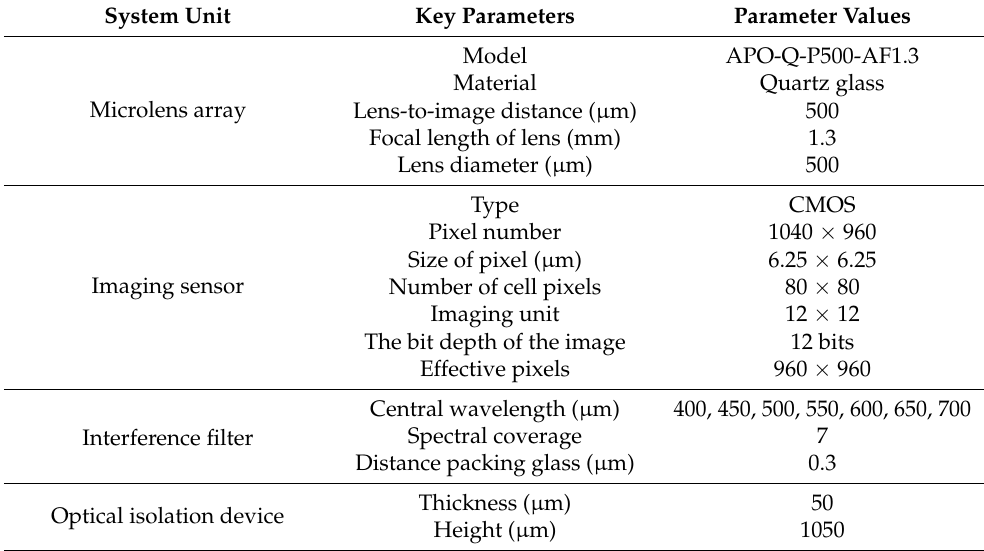
Figure 13. Photograph of the prototype multispectral TOMBO system. Table 1. Characteristic parameters of the compact TOMBO multispectral compound eye imaging system.